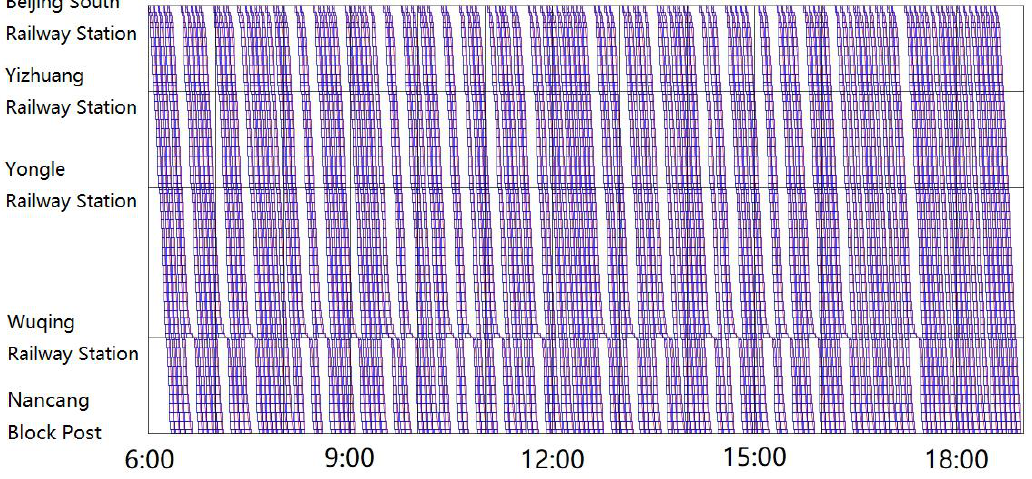
Figure 9. Timetable of the Beijing – Tianjin Intercity Railway during the minimum occupation time.